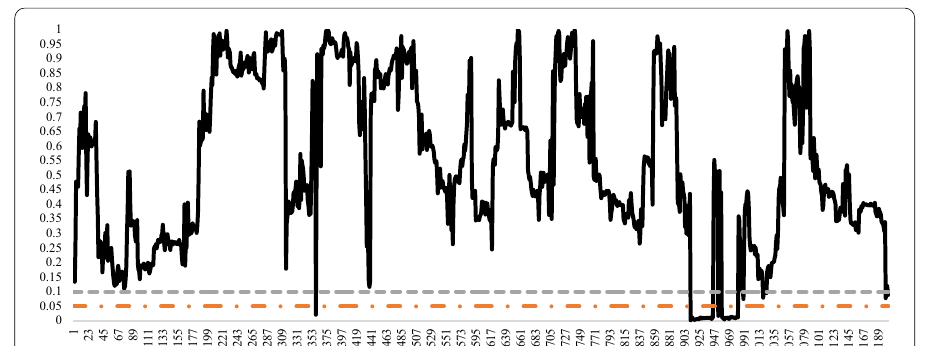
Fig. 10 The evolving p values of the AQ test statistic checked for the Ethereum (ETH) in 150-day window length